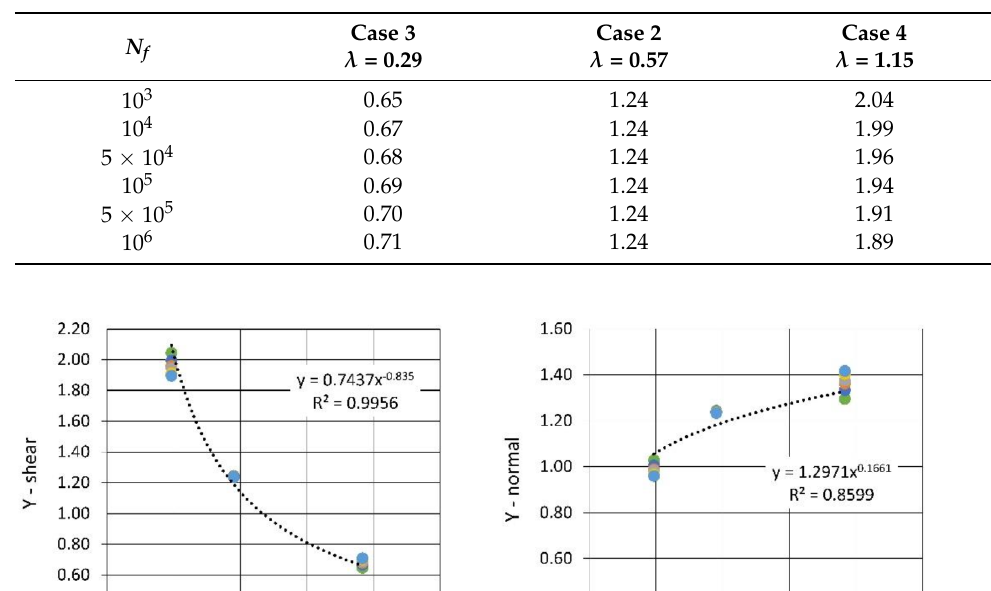
Table 10. Y shear variation with λ and N f .